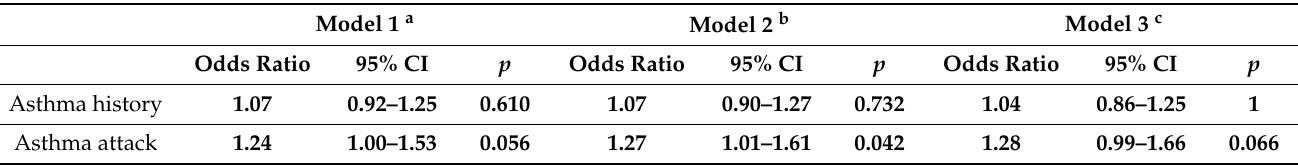
Table 3. Association between asthma and suicidal